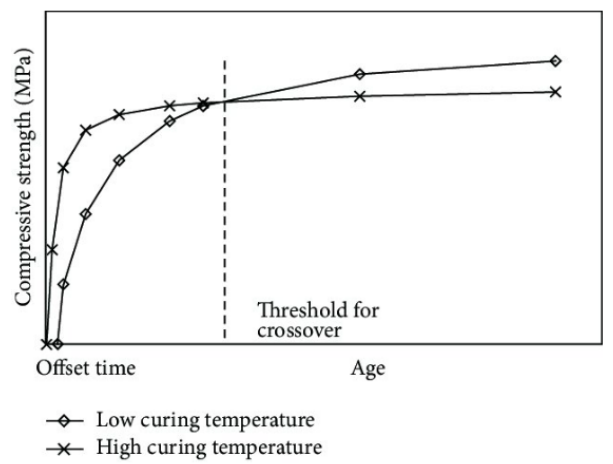
Figure 2. COE during strength development of concrete due to different initial curing temperatures. Adapted with permission from [19], Hindawi,